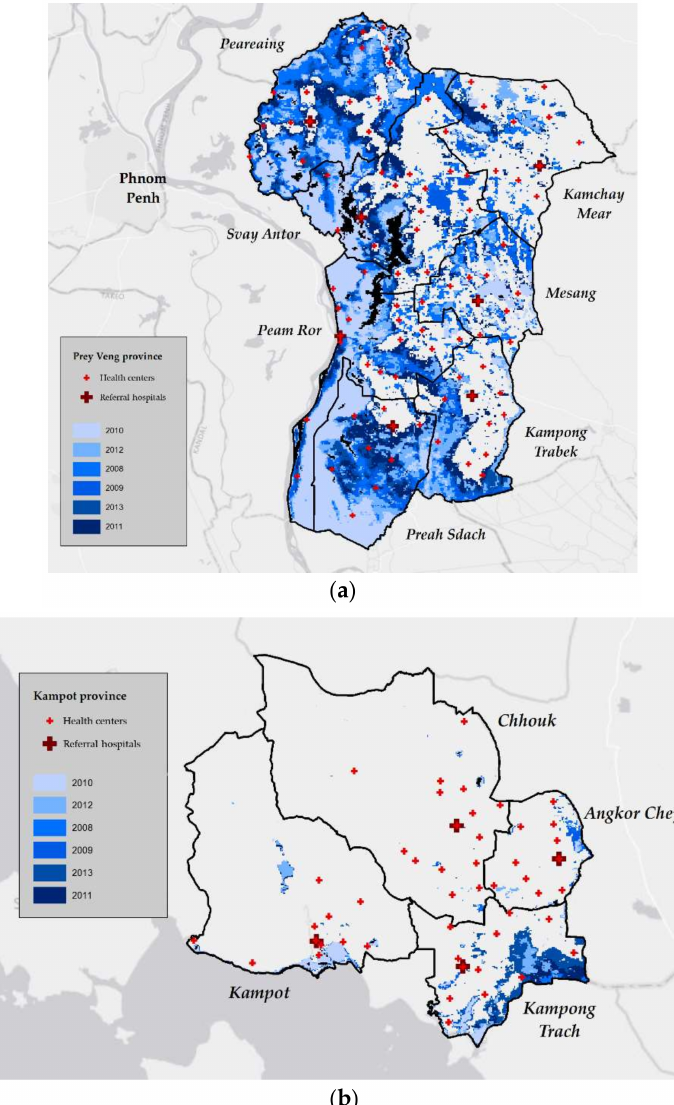
Figure 1. The total extent of flood water per year, and the location of healthcare facilities in 2010, in ( a ) Prey Veng province and ( b ) Kampot